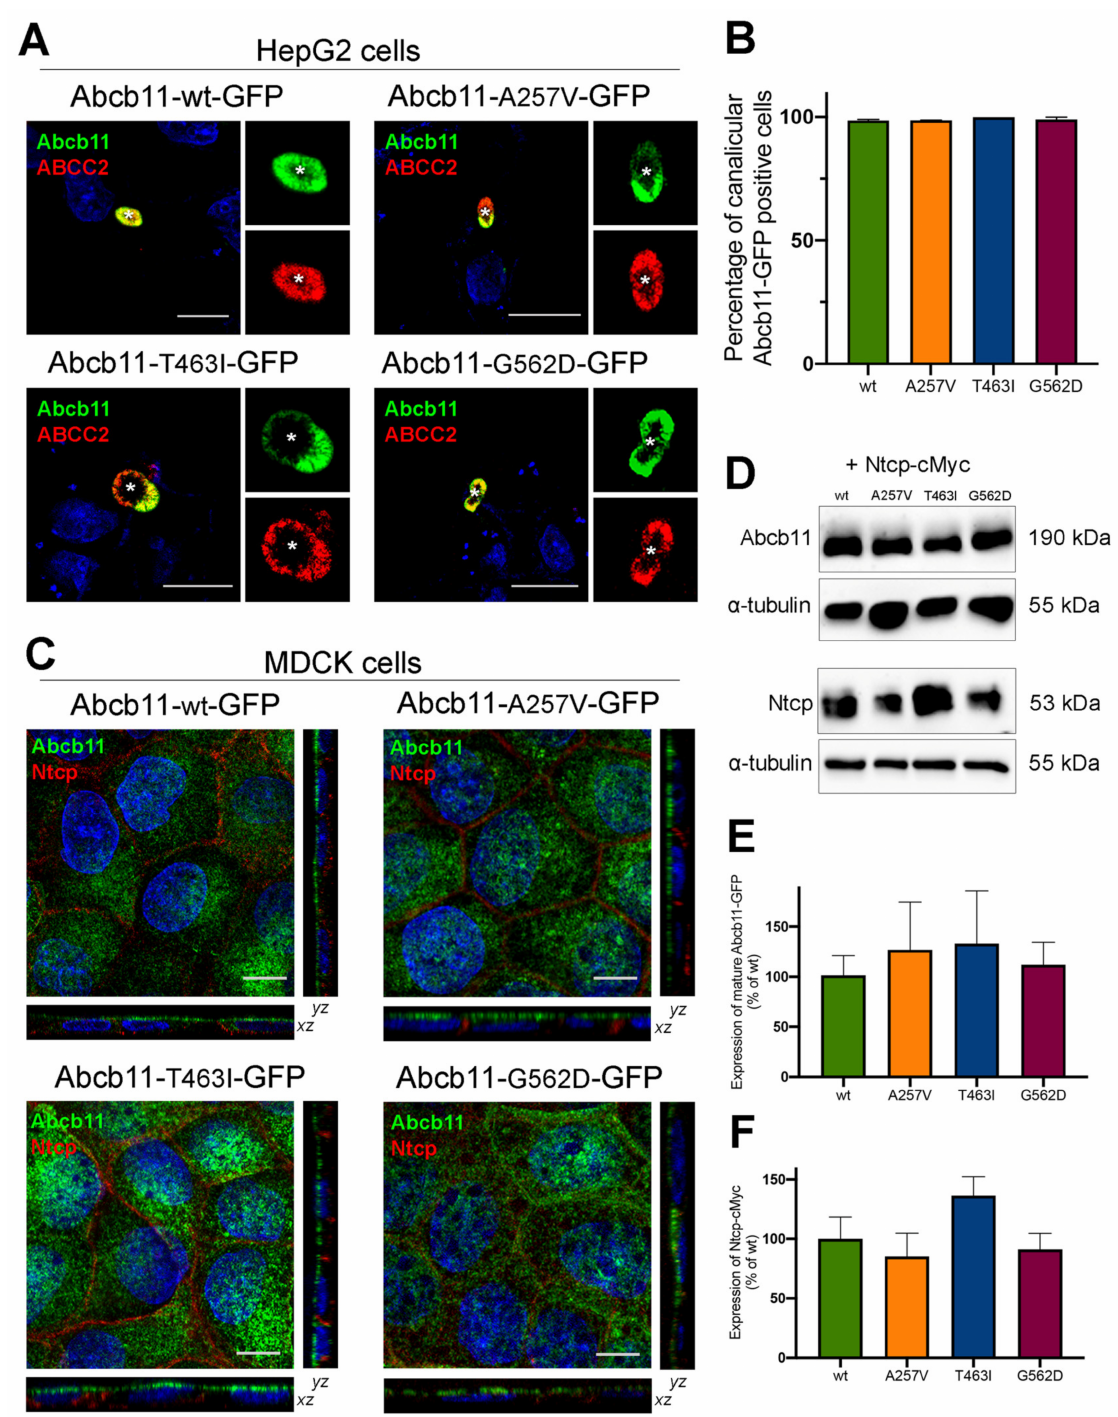
Figure 2. Abcb11 variants are expressed at the canalicular/apical membrane. ( A ) HepG2 cells were transiently transfected with Abcb11-GFP-encoding plasmids (wt and variants). Twenty-four hours later, cells were fixed and permeabilized. Immunolabelling of Abcb11-GFP (green) and endogenous ABCC2 (red) was visualized and analyzed using confocal microscopy. Nuclei shown in the merged images were labelled with Hoechst 33,342 (blue). This panel is representative of at least three independent experiments per condition. Dashed squares indicate magnification shown in the small right panels. Stars indicate canalicular structures. Bars: 10 µ m. ( B ) Quantification of ( A ). Among Abcb11-GFP-positive cells forming canaliculi, the percentage of cells expressing Abcb11-GFP at